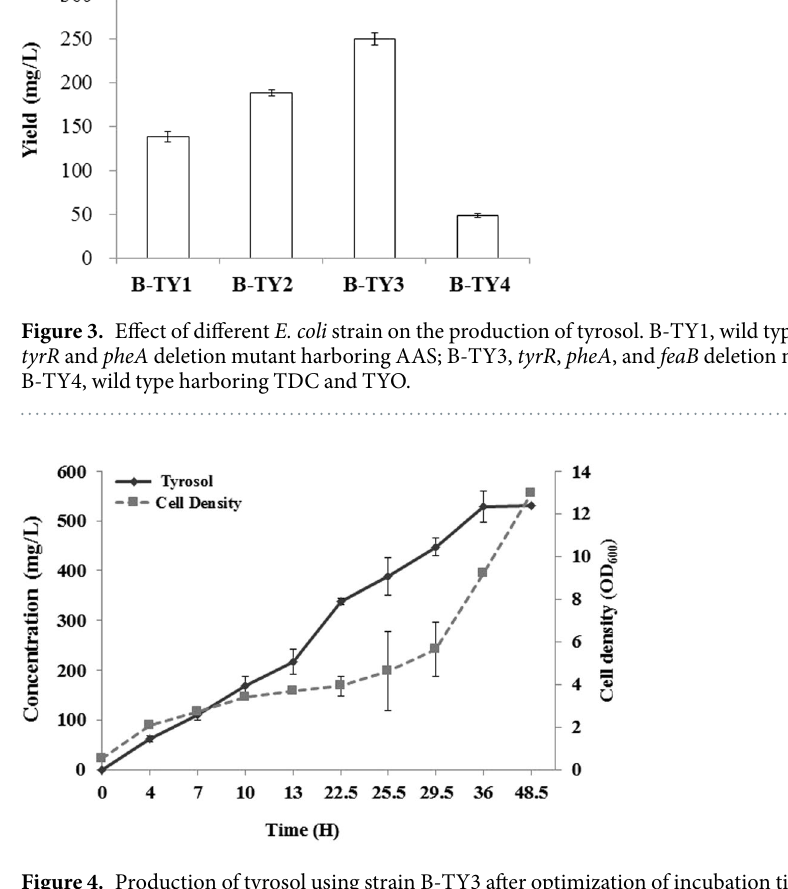
Figure 4. Production of tyrosol using strain B-TY3 after optimization of incubation time and cell concentration.